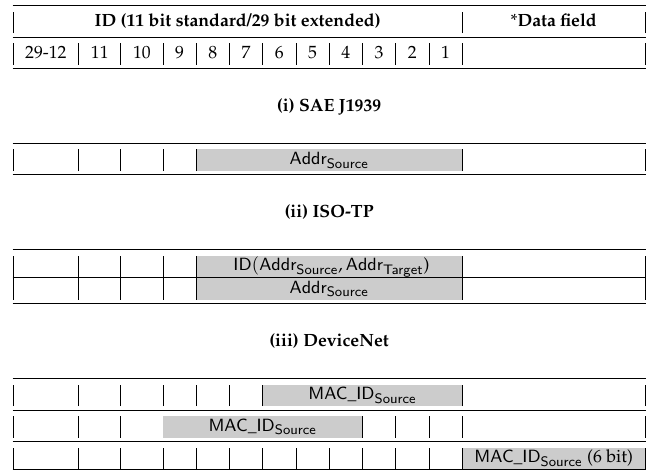
Figure 3. Frame format with node identity as defined by the higher layer protocols of SAE J1939, ISO-TP and